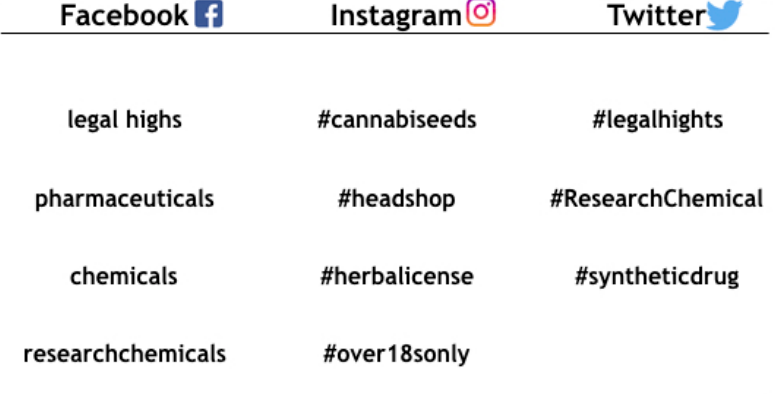
Figure 2. Keywords and hashtags in social networks with explicit content on NPS.